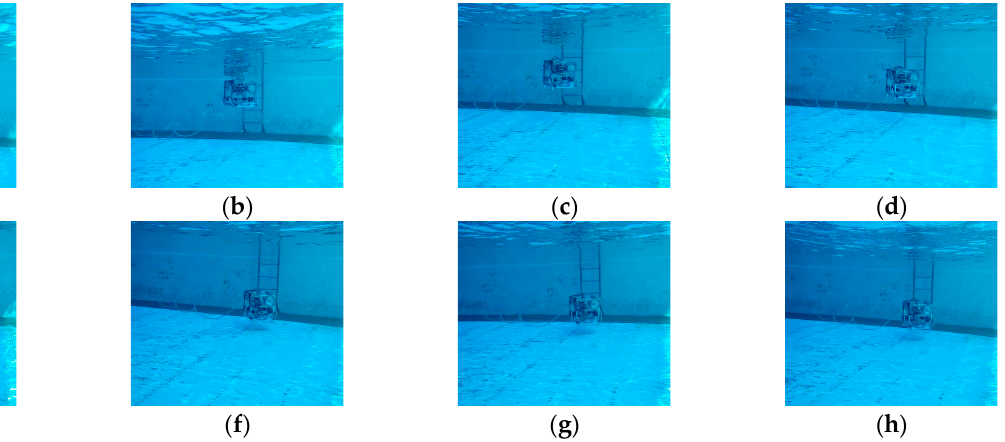
Figure 10. Station-keeping experiment. ( a ) Start diving at the depth of − 0.3 m. ( b ) Dive to − 0.4 m. ( c ) Dive to − 0.5 m. ( d ) Dive to − 0.6 m. ( e ) Dive to − 0.7 m ( f – h ) Station keeping at − 0.75 m.